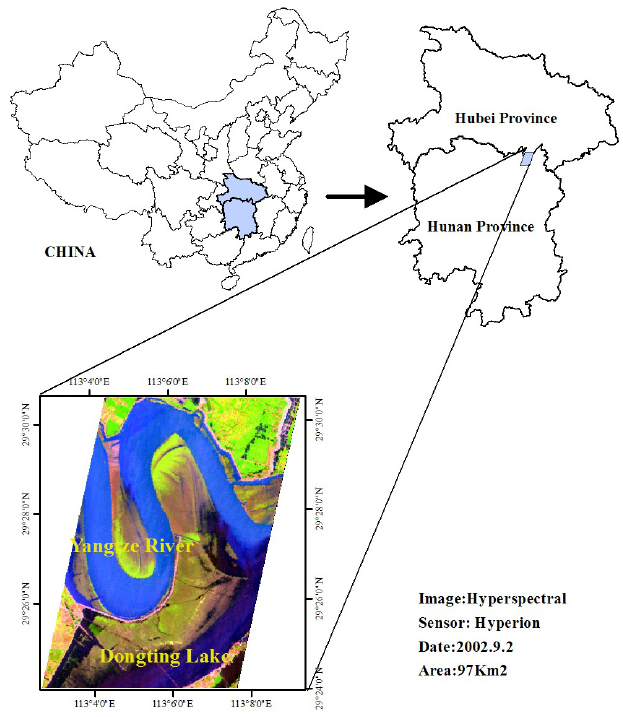
Figure. 3 The study area and